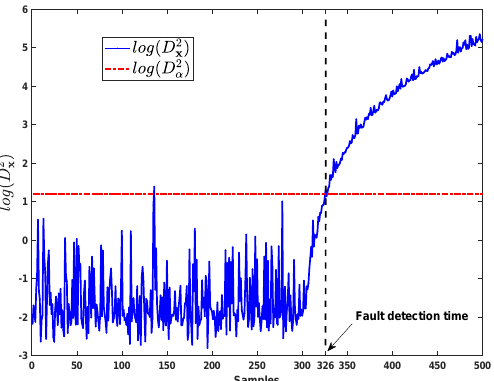
Figure 8. The fault detection results based on kNN for case 3 of numerical simulation.